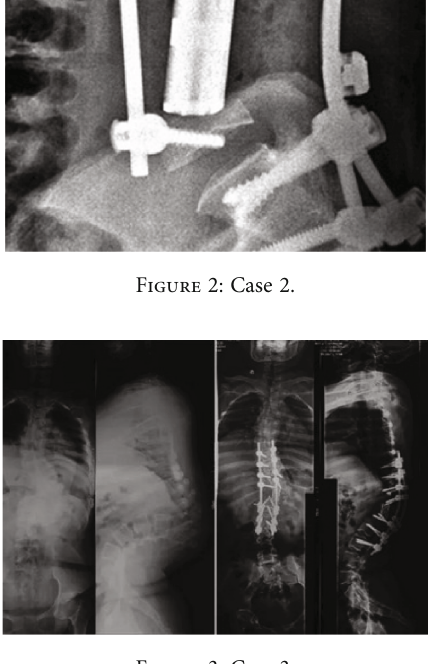
Figure 3: Case 3.